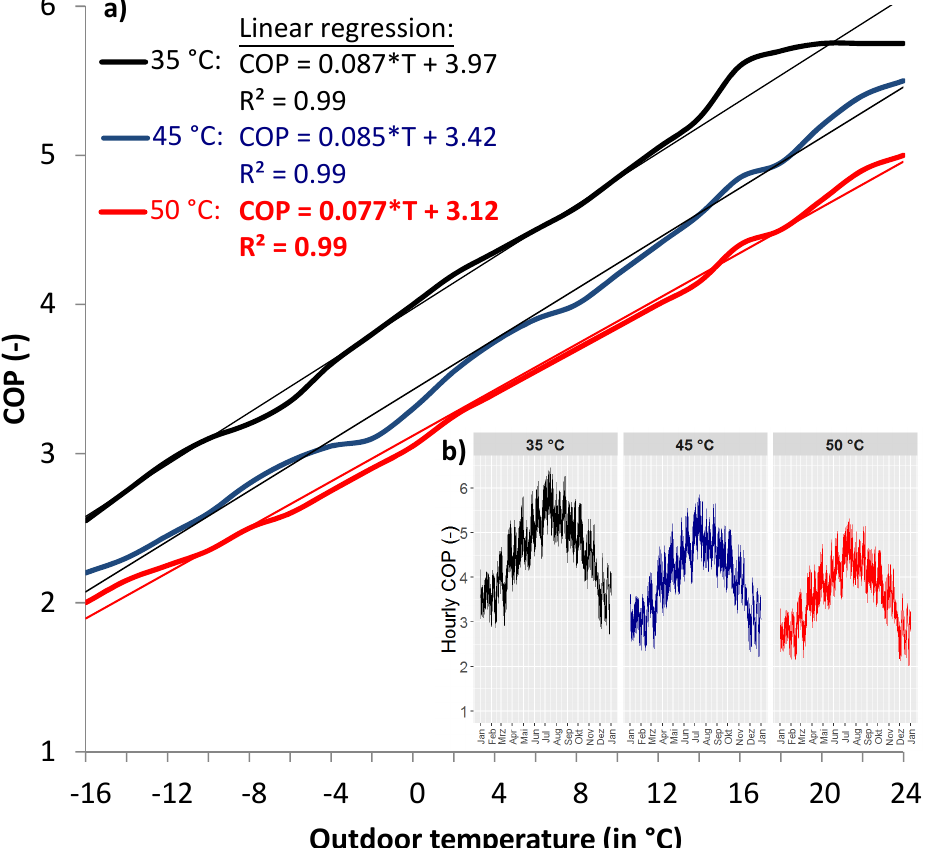
Figure 8. ( a ) Coefficient of performance (COP) of a state-of-the-art air-water heat pump [44] as a function of the ambient air temperature at three forward flow temperatures of 35 °C, 45 °C, and 50 °C. ( b ) Hourly COP of the heat pump in ( a ) for 35 °C, 45 °C, and 50 °C depending on the hourly ambient air temperature of “population-weighted” Switzerland in 2010 from Gelaro et al.